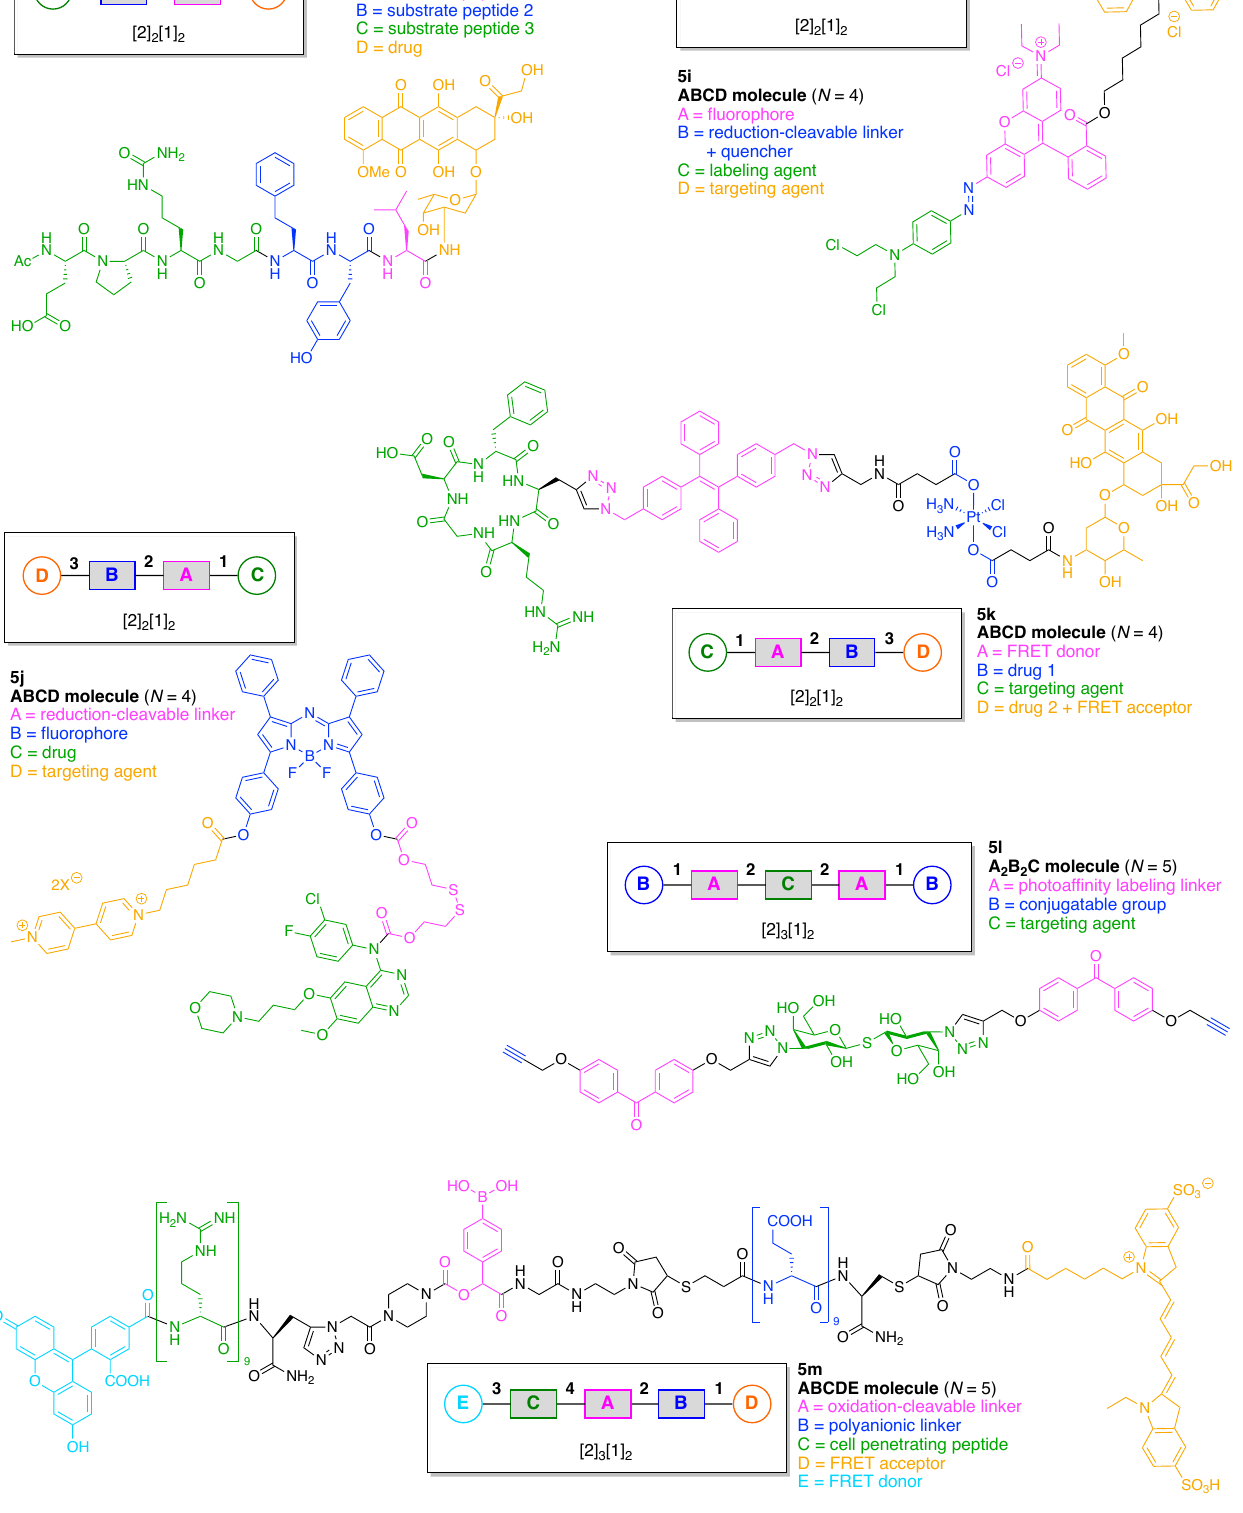
Figure 10. Six linear multifunctional molecules (no hubs) of graphs [2] 2 [1] 2 and [2] 3 [1] 2 . A mitochondria-targeted DNA alkylating agent ( 5i ) that is activated by hypoxia was developed for delivery to tumors and the mitochondria therein (Figure 10) [65]. The agent